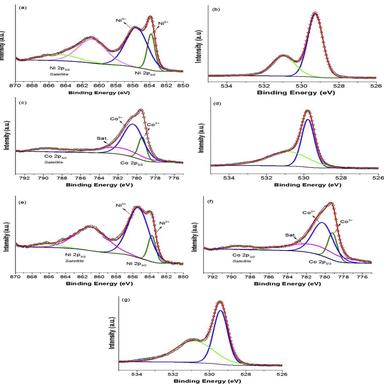
XPS spectra (a) Ni 2p3/2 and (b) O 1s of NiOeP; (c) Co 2p3/2 and (d) O 1s of Co3O4eP; (e) Ni 2p3/2, (f) Co 2p3/2 and (g) O 1s of NiCo2O4eP (P stands for PGR).